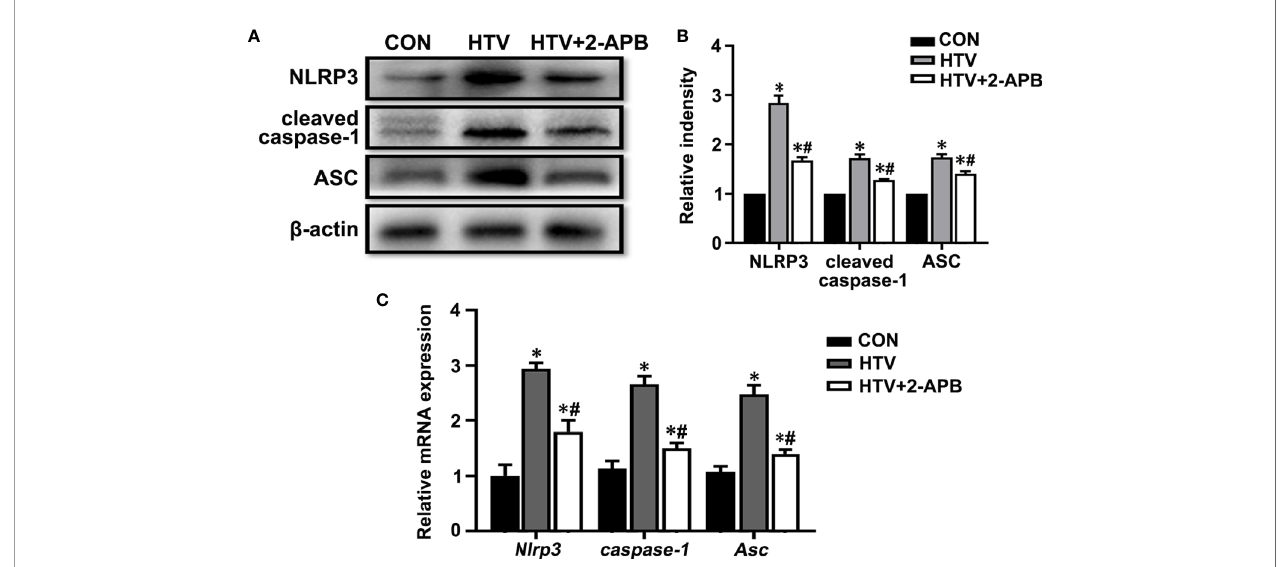
FIGURE 8 | 2-APB inhibits NLRP3 in fl ammasome activation in HTV-treated mice. (A, B) Representative immunoblots of NLRP3, cleaved caspase-1and Asc in lung extracts from CON, HTV and HTV+2-APB group and densitometric analyses of NLRP3, cleaved caspase-1and Asc. (C) Levels of NLRP3, caspase-1 and Asc mRNA. Data are expressed as means ± SD (n = 6 per group). * P < 0.05 vs . CON group. # P < 0.05 vs . HTV group.